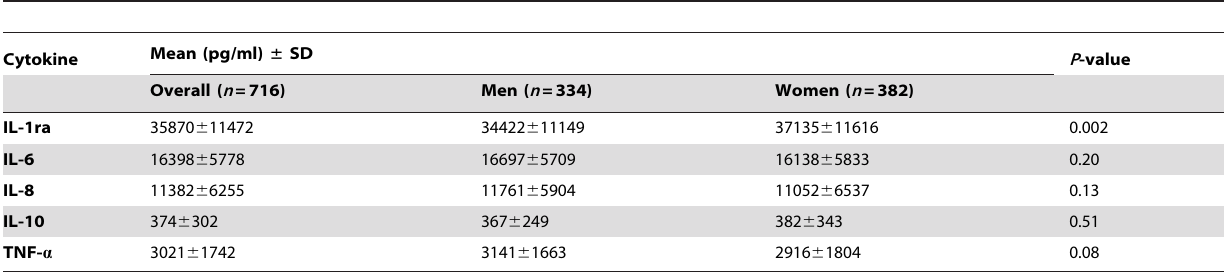
Table 1. The untransformed cytokine levels (pg/ml) measured in supernatants after 24 hours LPS-stimulation from the healthy individuals included in this genome-wide association study.